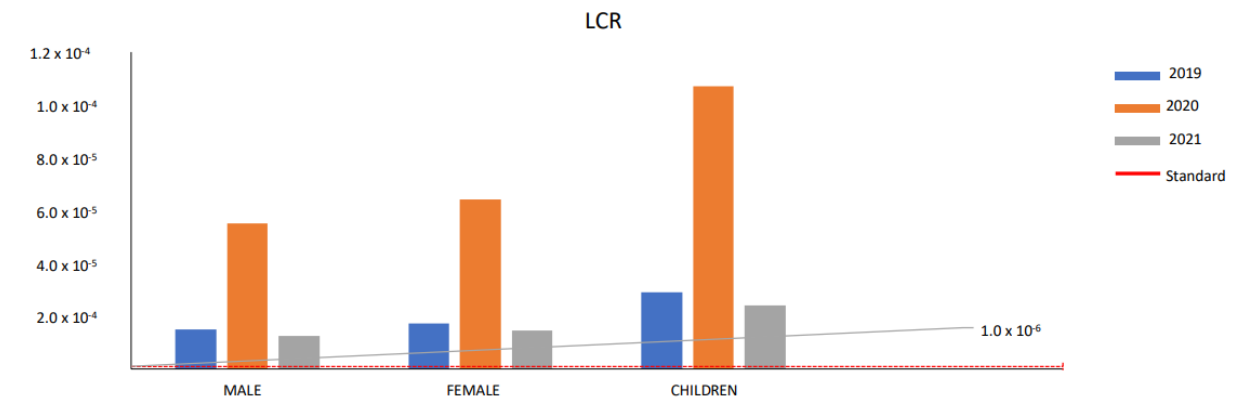
Figure 5. Lifetime cancer risk value for different gender for the years 2019, 2020, and 2021. For males, the total LCR values for benzene at all monitoring stations were calculated as 1.49 × 10 − 5 , 5.51 x 10 − 5 , and 1.24 × 10 − 5 , whereas the values for toluene were calculated as 1.5 × 10 − 4 , 1.57 × 10 − 4 , and 1.5 × 10 − 4 , for 2019, 2020, and 2021, respectively. The LCR values for benzene at all monitoring stations varied from 5.41 × 10 − 6 to 2.32 × 10 − 5 , from 1.24 × 10 − 6 to 4.22 × 10 − 4 , and from 2.36 × 10 − 6 to 2.26 × 10 − 5 for 2019, 2020, and 2021, respectively. The LCR values for benzene at all monitoring stations were estimated as the lowest for AL and the highest for SP in 2019, while in 2020 they were the lowest for BW and the highest for NL, and in 2021 they were the lowest for PG and the highest for SP. The results indicated that LCR values were higher during the pandemic period than those in the pre- and post-pandemic periods. For benzene, some monitoring stations had LCR values that exceeded the standard LCR value as prescribed by the CPCB (1.0 × 10 − 6 ), such as values of 1.23 × 10 − 5 , 1.78 × 10 − 5 , 1.92 × 10 − 5 , 1.93 × 10 − 5 , 1.93 × 10 − 5 , and 2.33 × 10 − 5 for NL, WZ, SON, MD, OKH, and SP, respectively, in 2019; 1.08 × 10 − 5 , 1.27 × 10 − 5 , 1.35 × 10 − 5 , 1.35 × 10 − 5 , and 1.99 × 10 − 5 for MD, OKH, SON, WZ, and SP, respectively, in 2020; 1.11 × 10 − 5 , 1.28 × 10 − 5 , 1.55 × 10 − 5 , 1.69 × 10 − 5 , 1.73 × 10 − 5 , and 2.26 × 10 − 5 for WZ, NL, SON, MD, OKH, and SP, respectively, in 2021. calculated to be 1.73 × 10 − 5 , 6.42 × 10 − 5 , and 1.44 × 10 − 5 , whereas the values for toluene